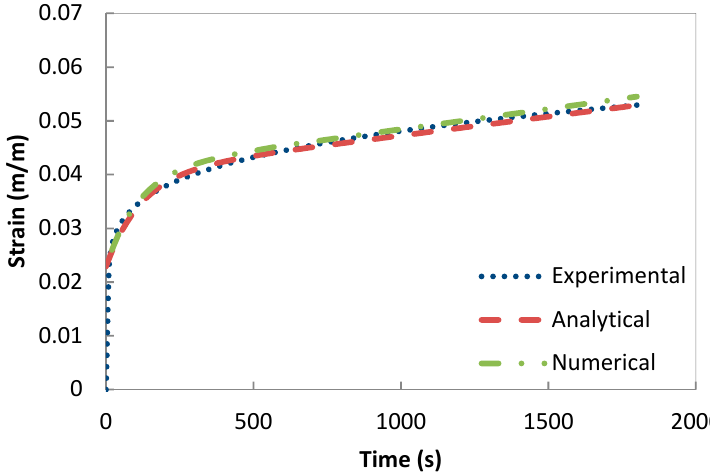
Figure 8. Modelling the creep component of PB3 by a Burger model.